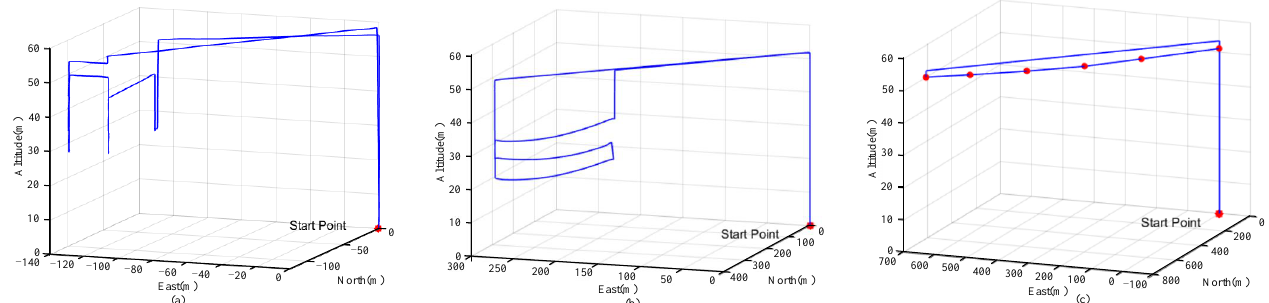
Figure 11. ( a ) The trajectory of fine inspection; ( b ) The trajectory of arc-chasing inspection; ( c ) The trajectory of channel inspection.The red points are mission points and the blue lines are the flight paths of the